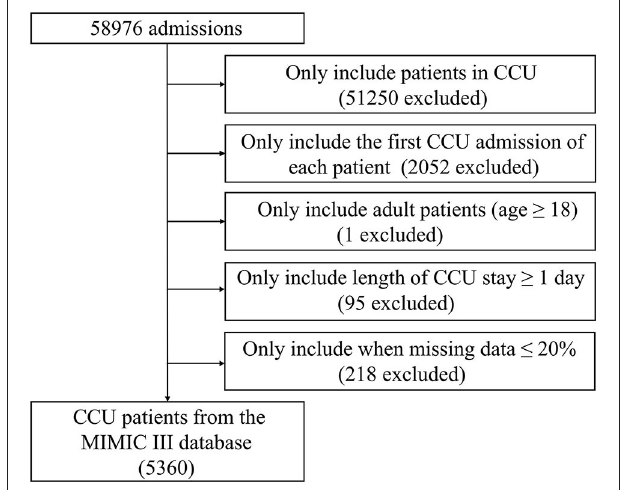
FIGURE 1 | Screening flowsheet of the study population. CCU, coronary care unit; MIMIC-III, Medical Information Mart for Intensive Care III.